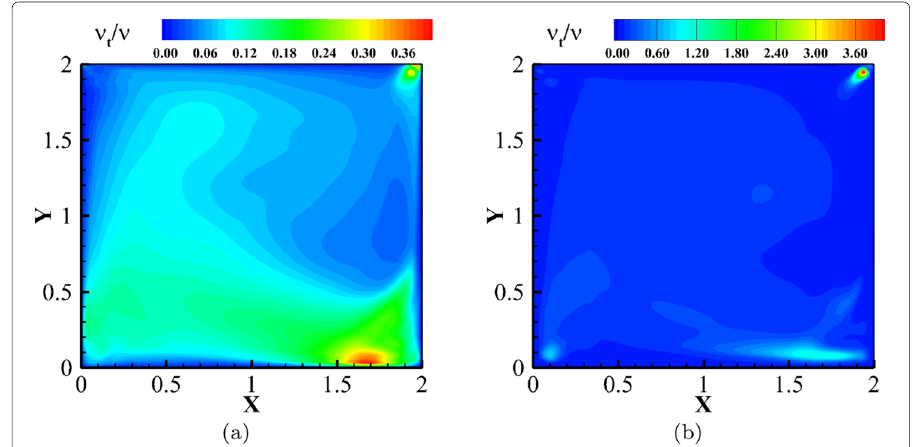
Fig. 22 Contours of the ν t /ν at the mid-plane Z = 1. a ) The Vreman model, 40 contours levels taken between 1 × 10 − 5 and 0.4. b The WALE model, 40 contours levels taken between 1 × 10 − 5 and